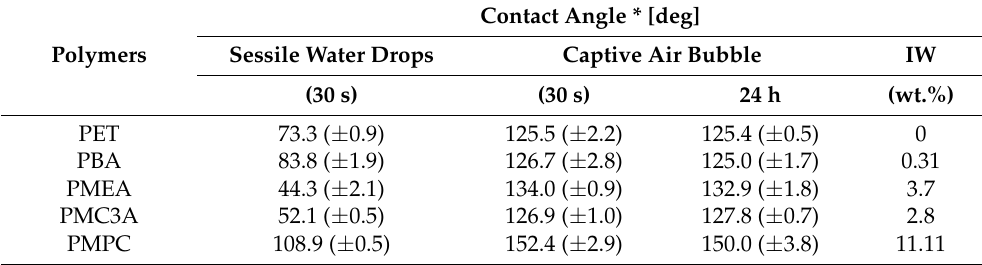
Table 1. Contact angle and water content of studied polymers. Contact Angle * [deg] Sessile Water Polymers